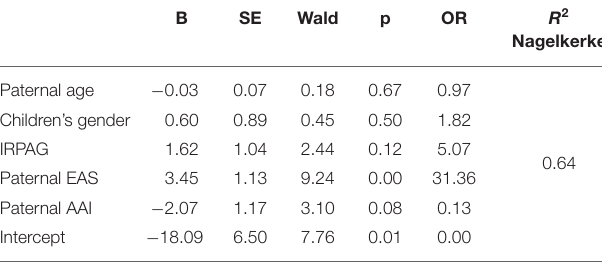
TABLE 5 | Logistic regression on paternal SSP